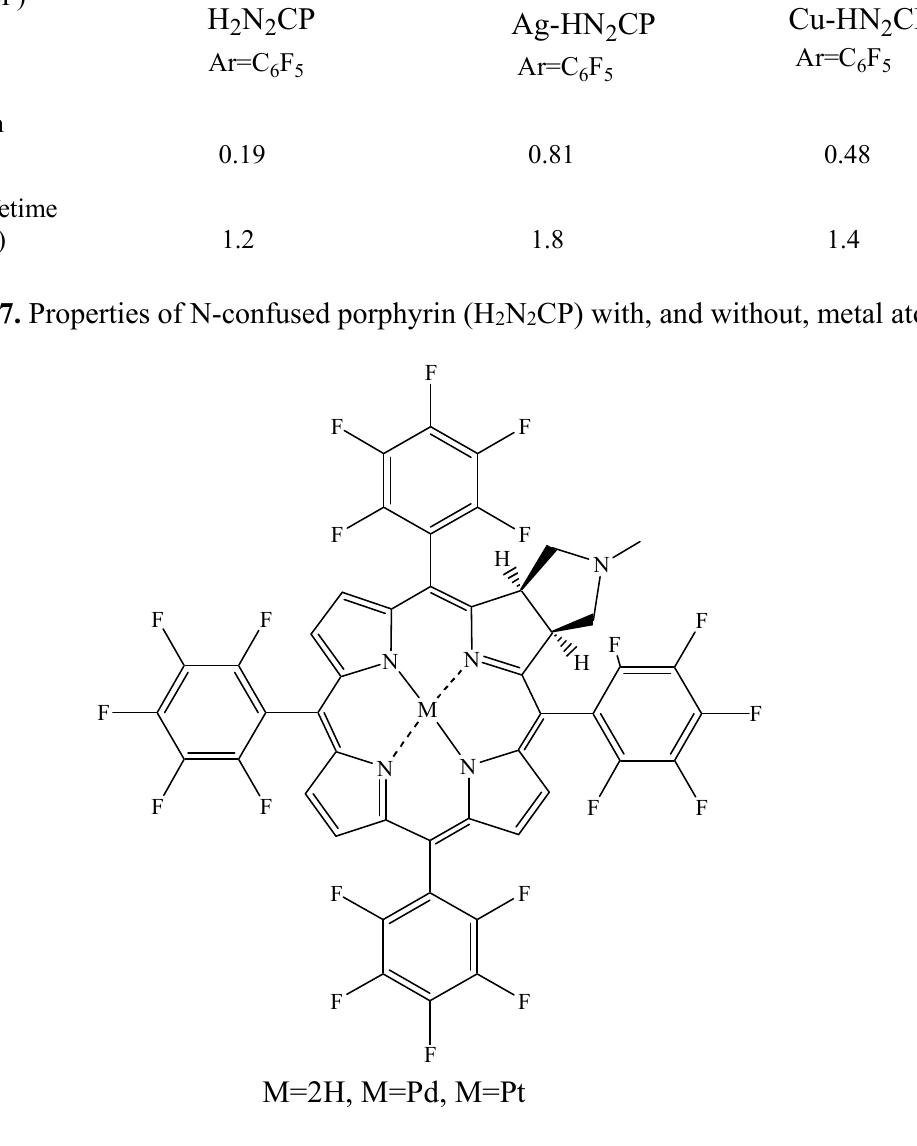
Figure 18. Pd- and Pt-complexed 5,10,15,20-tetrakis (pentafluorophenyl) porphyrin structures. Up to a 70% increase in 1 O 2 quantum efficiency was reported for Mg tetrabenzoporphyrin containing a pyridine ligand, Figure 19 [105]. Placing one or five Zn atoms into a picolylamine-based porphyrin raised the 1 O 2 quantum yield from the 0.5 to 0.82 and 0.92, respectively